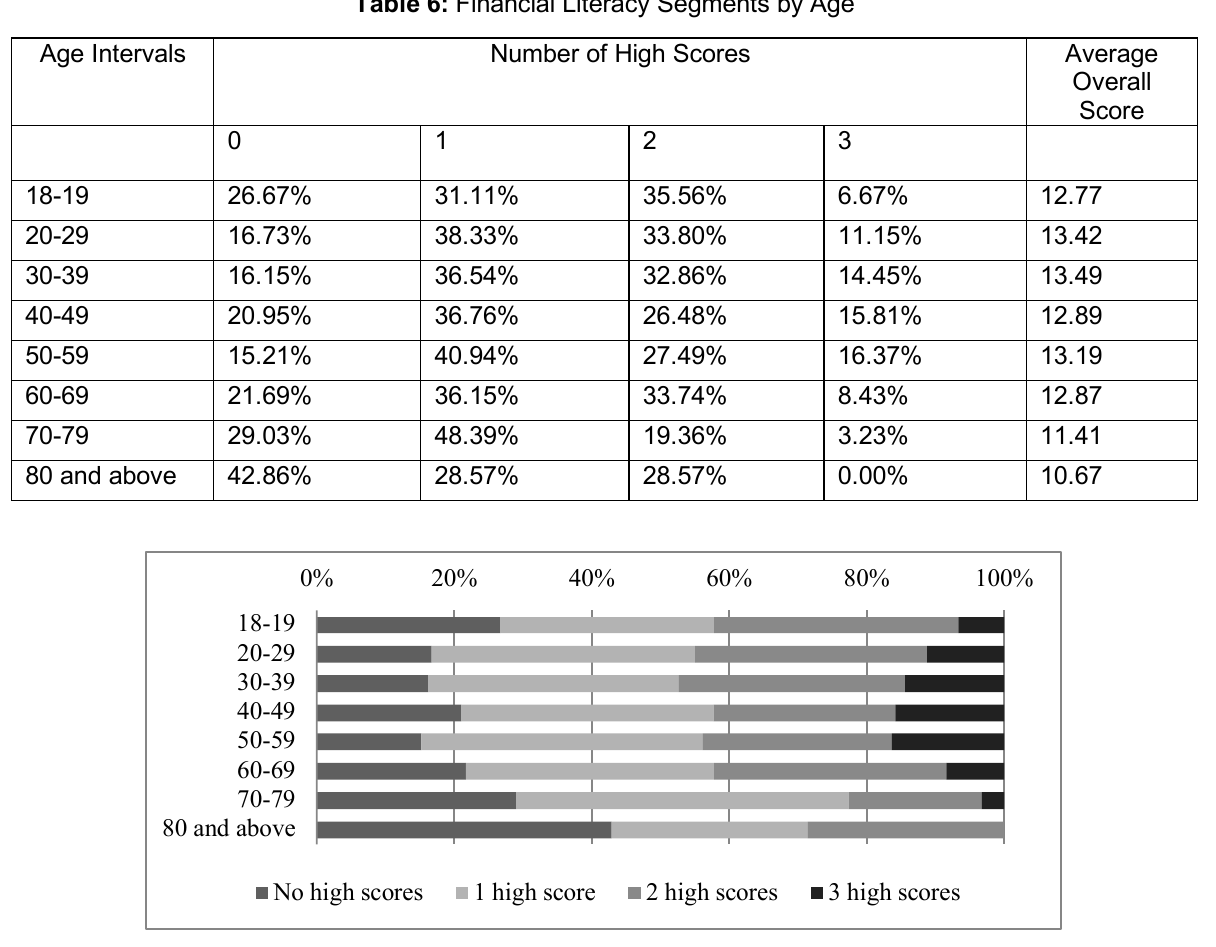
Figure 3: Financial Literacy Segments by